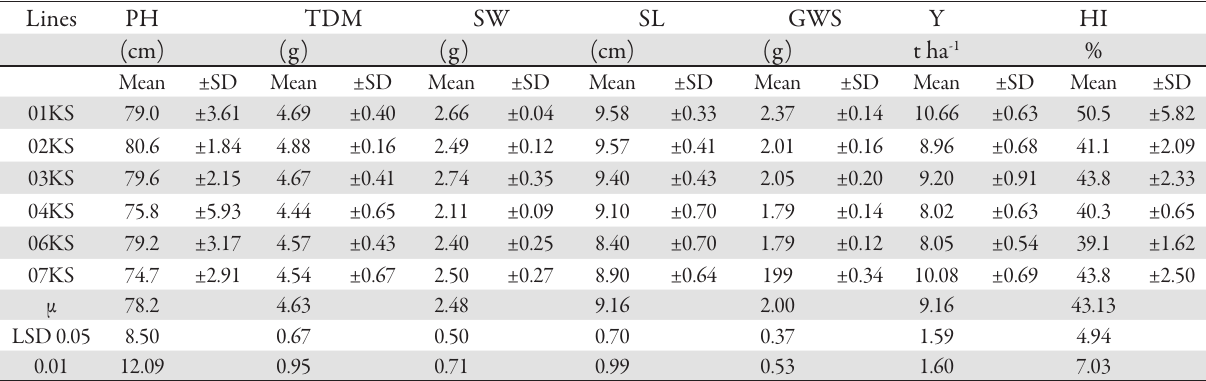
Tab. 2. Means and standard deviation for various related traits in six wheat genotypes lines Lines